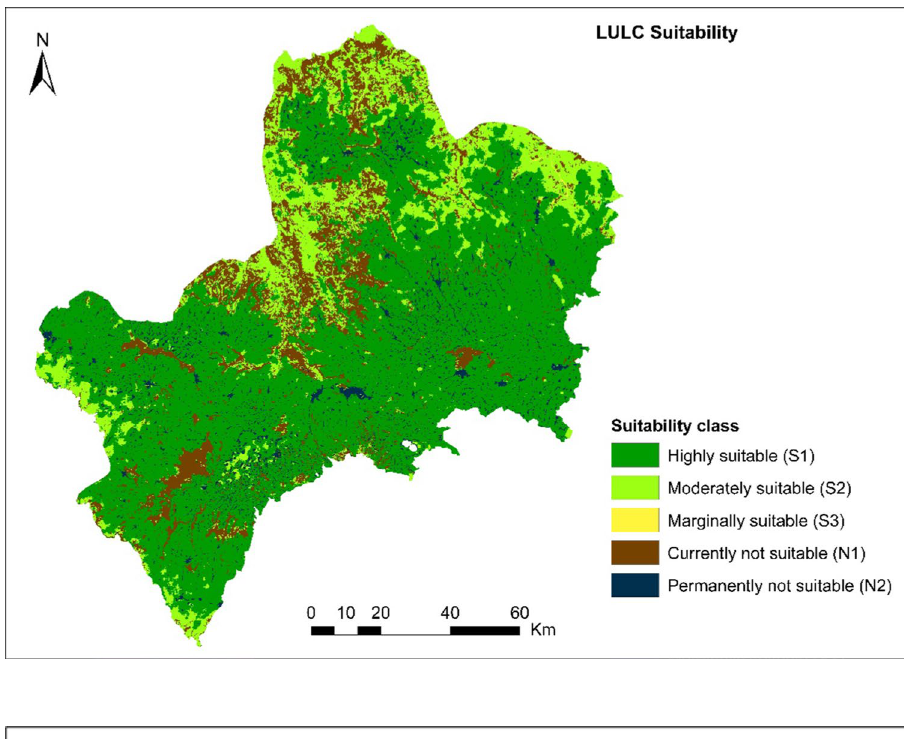
Fig. 9 Proximity to river suit- ability